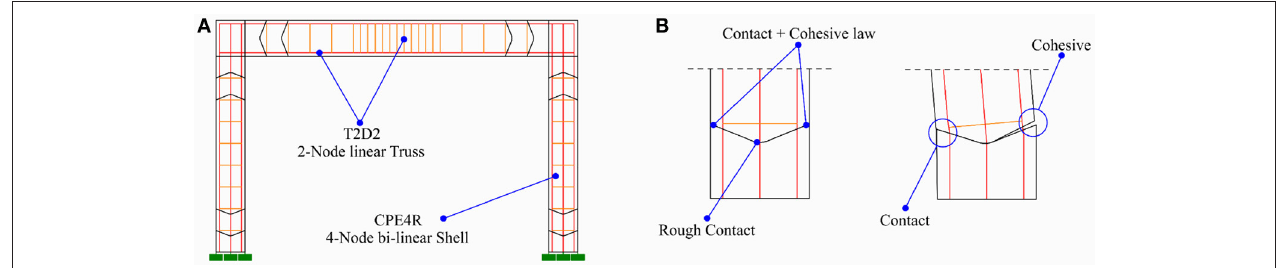
FIGURE 3 | (A) Numerical model and (B) interface interaction.